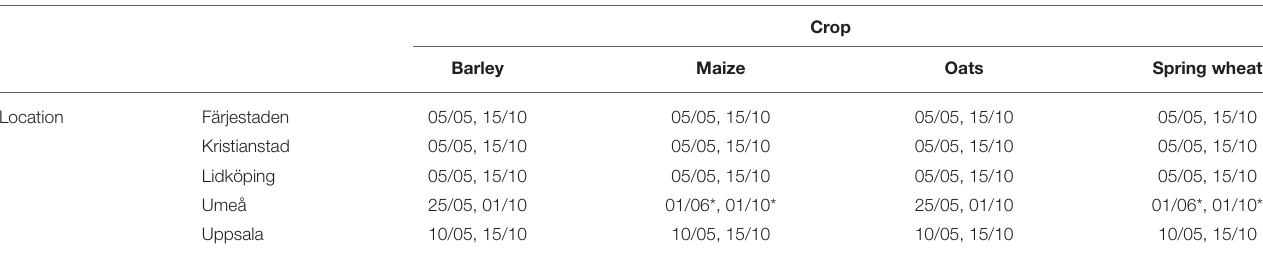
FIGURE 1 | Locations used in the study. Black circles indicate locations with soil sampling performed by the authors. The pink circle shows the location for which soil data were acquired from a previous report (Wiklert et al., 1983).